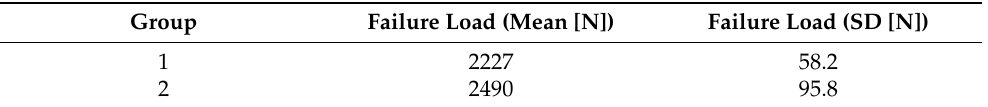
Table 1. Strength calculated from static testing (n = 3).